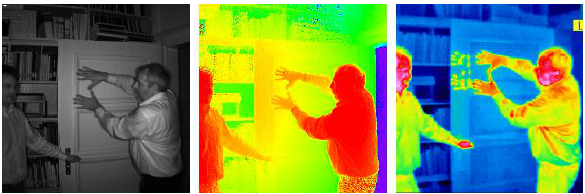
Figure 1. Visualization of the data captured with a TOF and a TIR camera: Normalized active intensity (NIR), range data and thermal intensity (TIR) (from left to right). The range increases from red pixels via yellow and green pixels to blue pixels. The thermal intensity is coded in RGB with intensity increasing from blue via green and red to white.